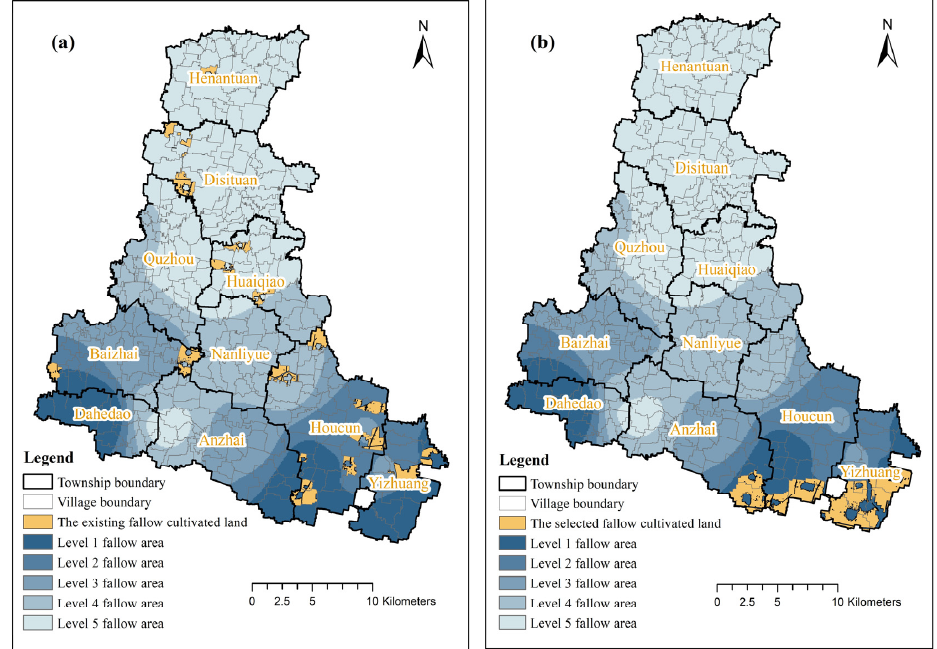
Figure 6. Spatial distribution of the existing fallow cropland ( a ) and the selected fallow cropland ( b ) in Quzhou County in 2018. ( b ) in Quzhou County in